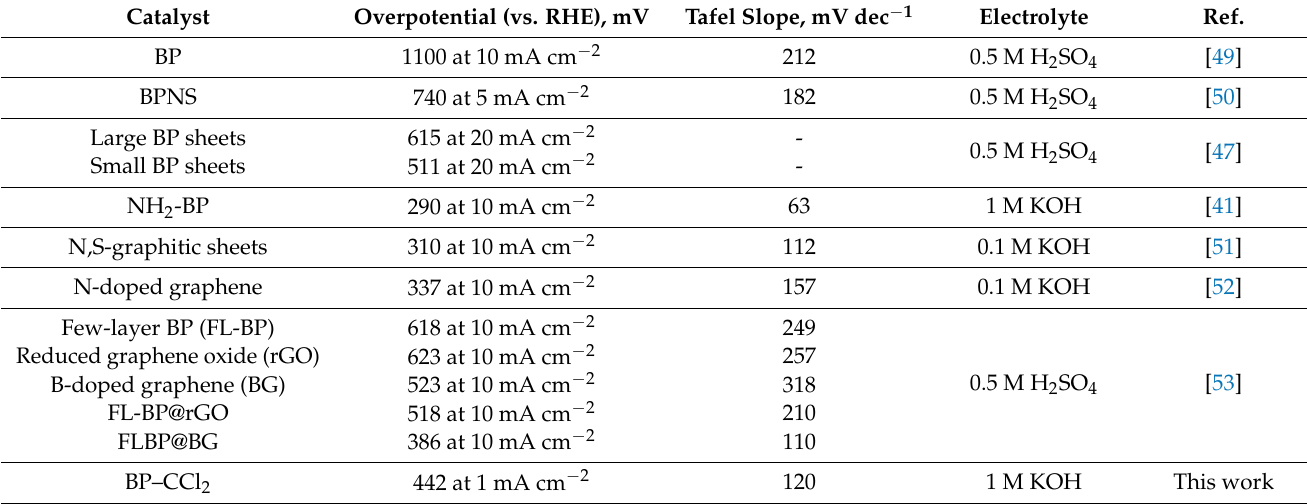
Table 2. Electrocatalytic HER performance of different metal-free